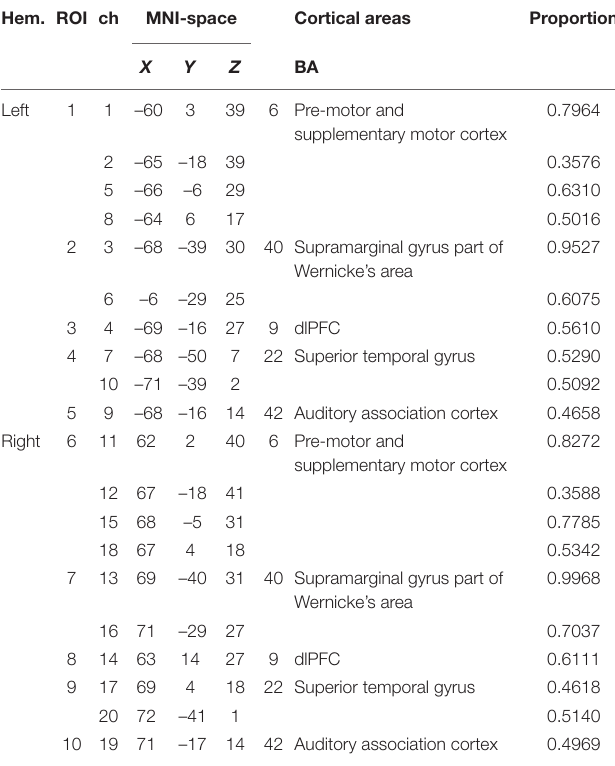
TABLE 1 | Coordinates and related Brodmann and anatomical areas (based on 25